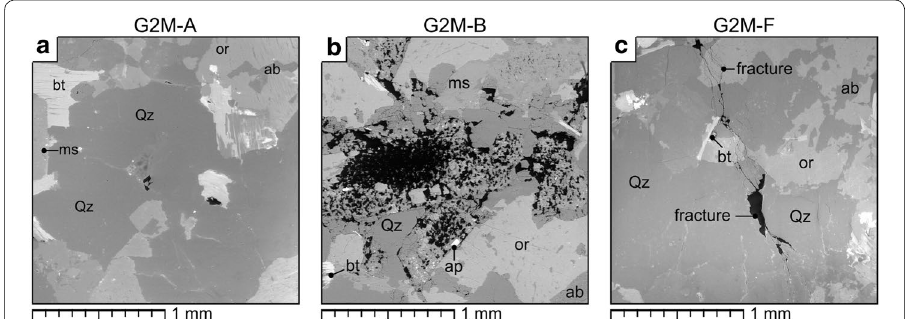
Fig. 2 Three classifications of granite collected at Schwarzenbach (Fig. 1). a – c Scanning electron microscope images of examples from each suite ( G2M-A, G2M-B, and G2M-F, respectively). Minerals identified using X-ray powder diffraction and energy-dispersive X-ray microanalysis: Qz biotite; ms muscovite; ap = =